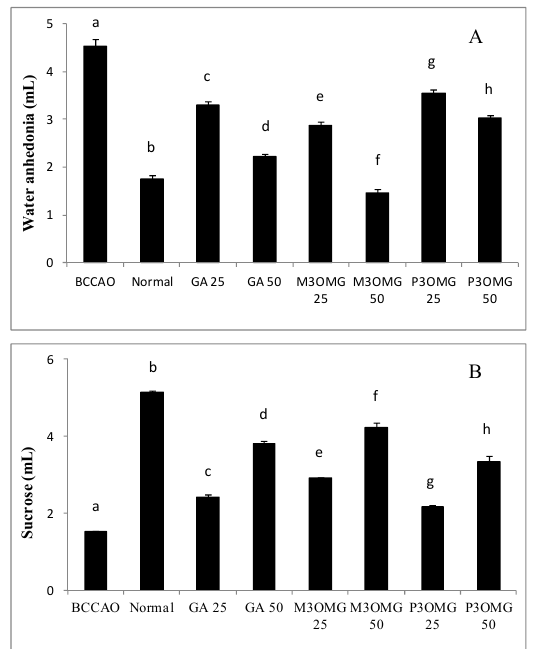
Figure 2. Volume of water ( A ) and sucrose solution ( B ) consumption in the stroke-induced anhedonia model. Data are shown as a mean (mL) ± SD ( n = 3); different letters indicate statistically significant differences ( p < 0.01) between the two groups.